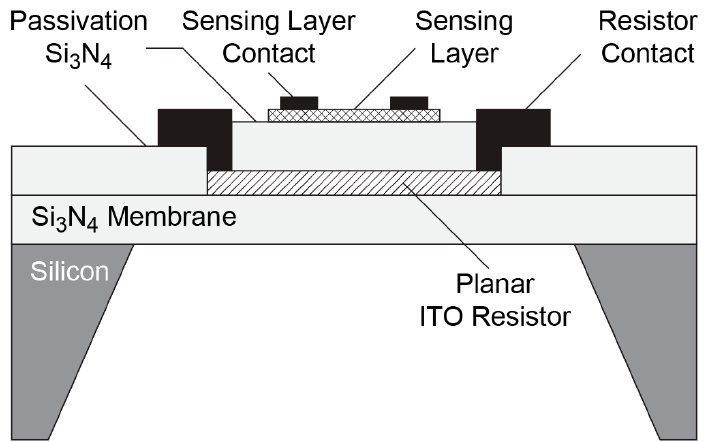
Figure 1. Cross-section of the gas sensor.